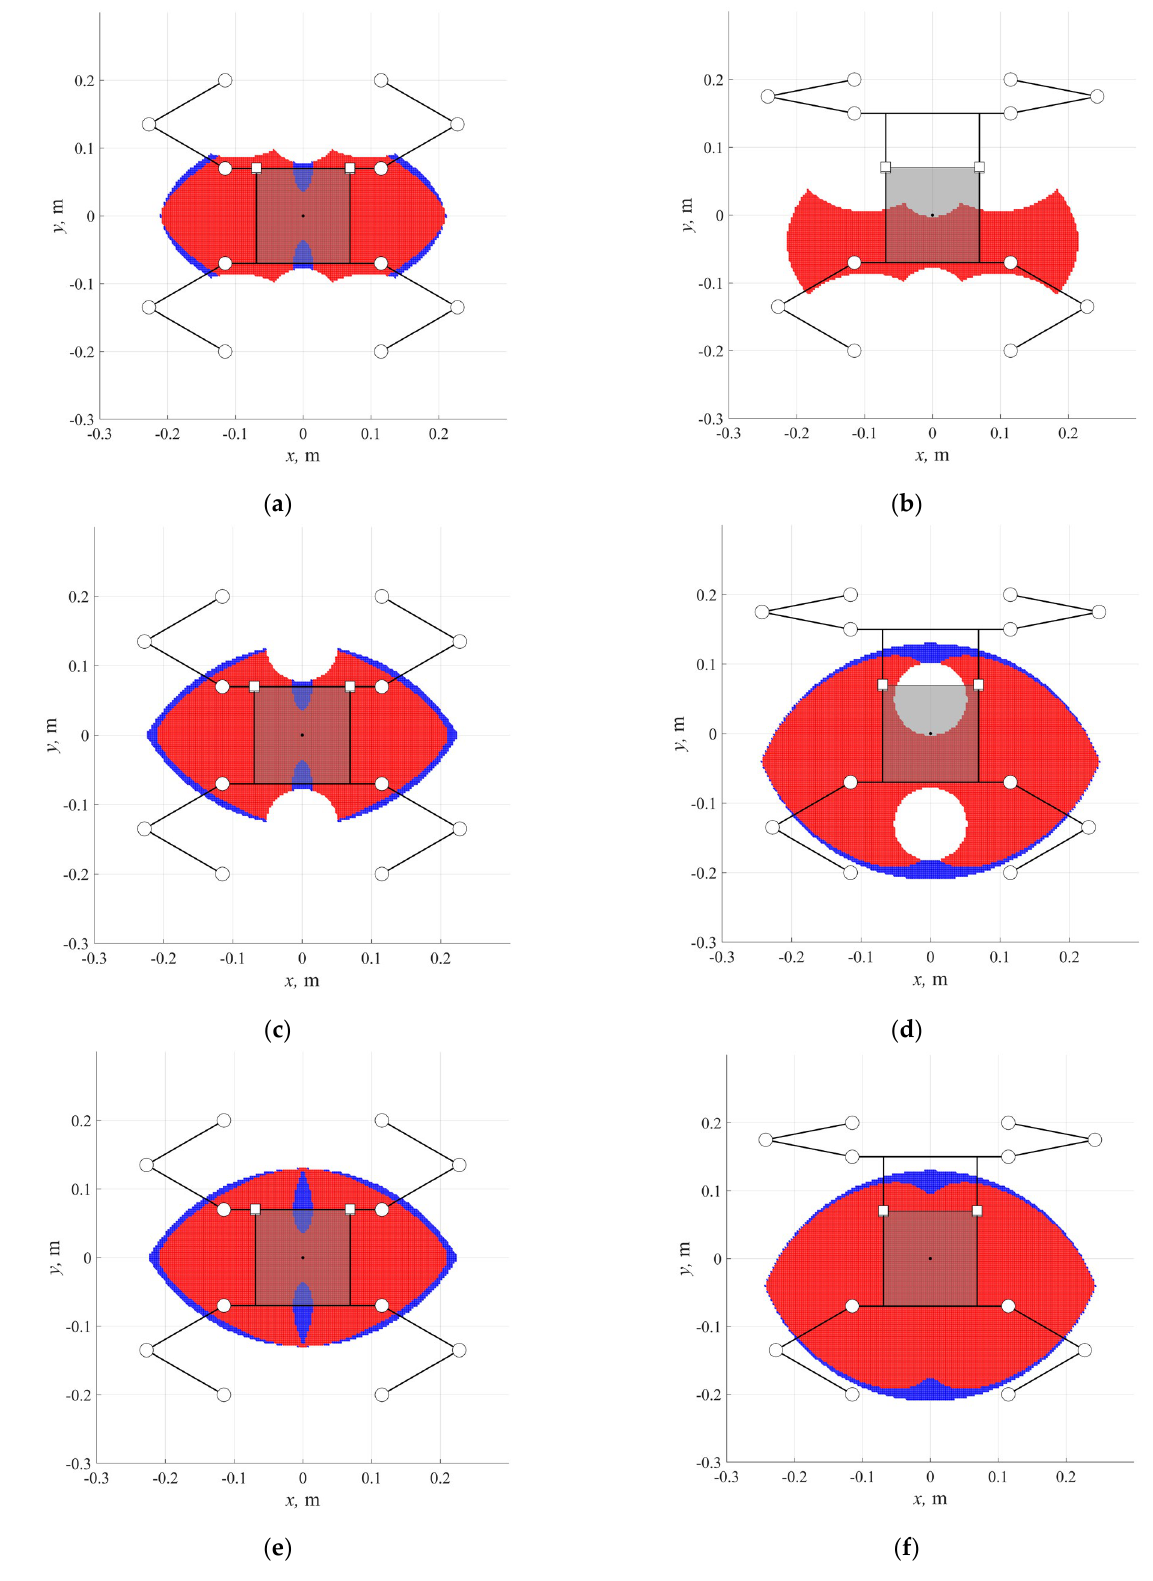
Figure 4. Shape and size of the workspace regarding the design choice (workspaces ( a , c , e ) con- structed for s = 0.140 m and workspaces ( b , d , f ) constructed for s = 0.220 m): ( a , b ) correspond to the manipulator model shown in Figure 1b; ( c , d ) correspond to the manipulator model shown in Figure 1c; ( e , f ) correspond to the manipulator model shown in Figure 1d.